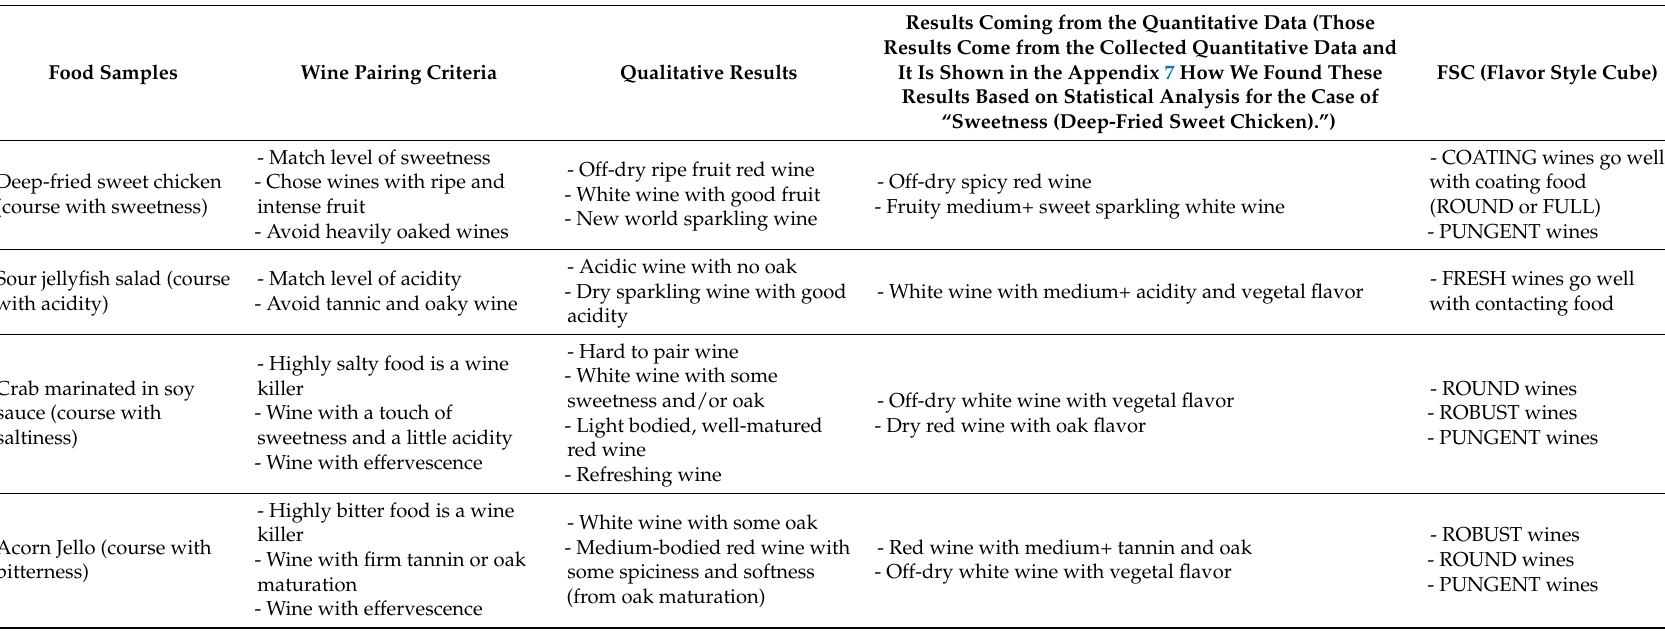
Table 4. The comparison of the Western criteria, the qualitative result, and the quantitative